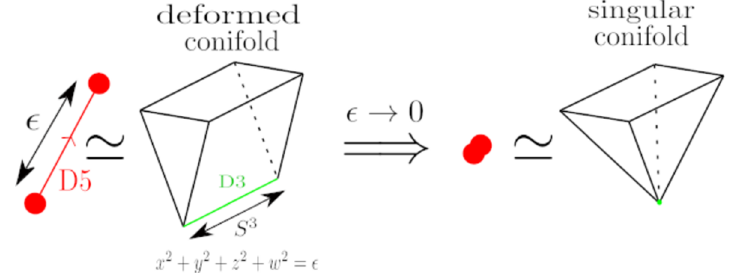
Figure 6 . Left: two monodromy defects separated by a small distance (cid:15) is dual to the deformed conifold. Right: two defects stacked on top of each other are dual to a singular conifold.